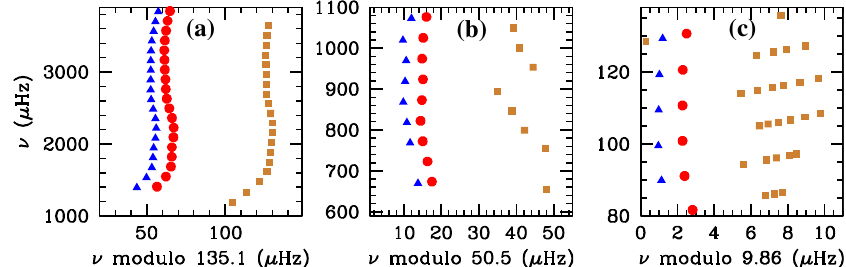
Fig. 39 The frequencies of three stars shown in the form of an ‘Échelle’ diagram. Échelle diagrams are plotted by dividing the observed power spectrum (or frequencies) of a star into frequency slices of width Δν and stacking the slices on top of each other. Red circles are (cid:2) = 0 modes, brown squares are (cid:2) = 1 and blue triangles are (cid:2) = 2 modes. a The Sun, b a subgiant and c a red giant. Note that for the Sun, a main sequence star, all the modes of a given degree line up. In the case of the subgiant, the (cid:2) = 1 modes show a break. This break is an “avoided crossing” and is a signature of the presence of mixed modes. Note the large number of (cid:2) = 1 modes in the red giant. These are all mixed modes and the frequencies of these modes depend on details of the buoyancy frequency profile